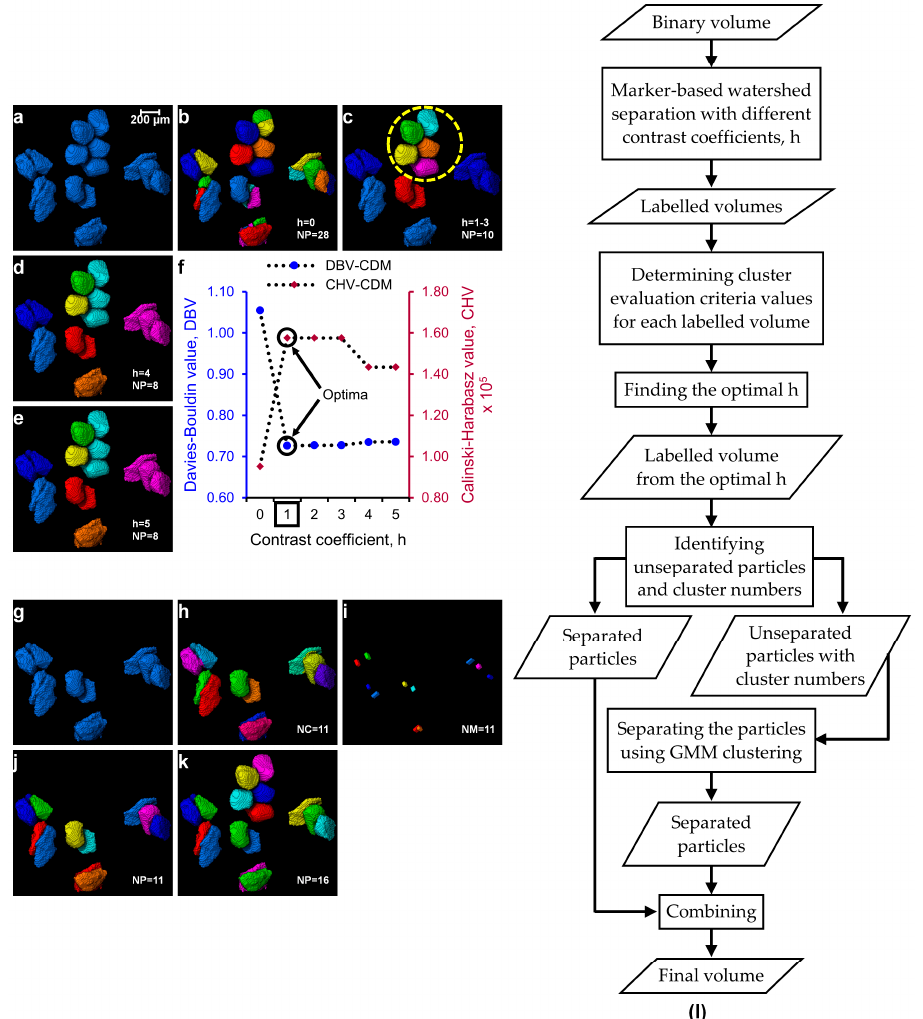
Figure 9. ( a ) Challenging groups of particles; ( b – e ) separation outcomes using the watershed method with h = 0 to 5; ( f ) optimal h -value based on the cluster evaluation values ( g ) remaining unseparated particle-groups; ( h ) GMM clustering; ( i ) generation of cuboid markers; ( j ) separation outcomes for the unseparated groups; ( k ) combined volume with all particles separated; and ( l ) flow chart showing the MPSM. [NP: no. of particles, NC: no. of clusters, NM: no. of markers].